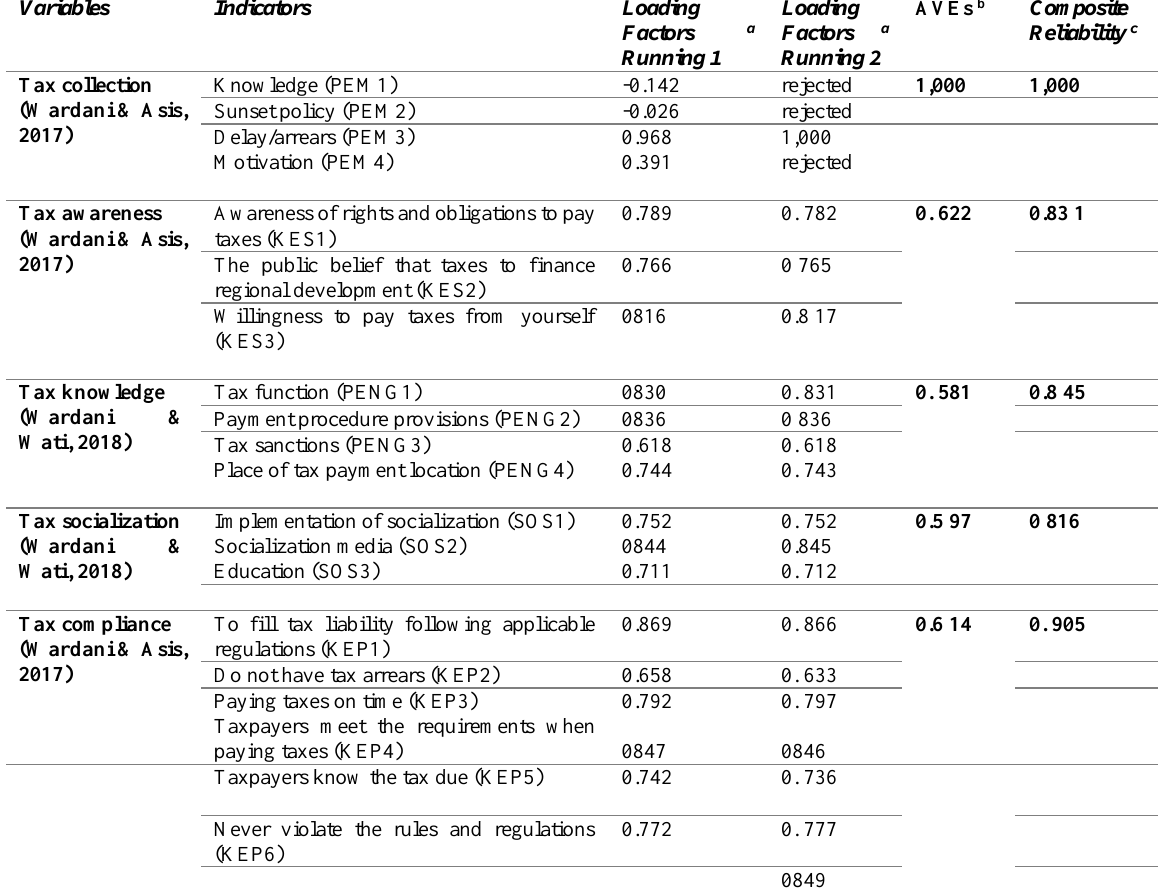
Table 7: Variables, Indicators , Loading Factors , AVEs, and Composite